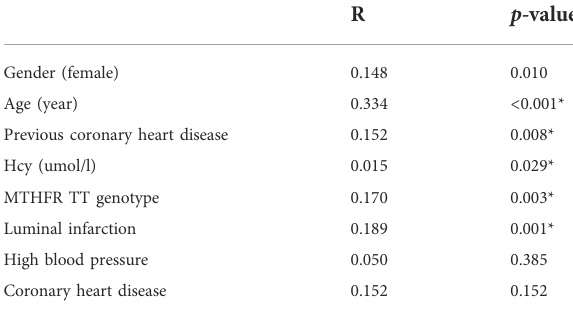
TABLE 3 Spearman correlation analysis of white matter